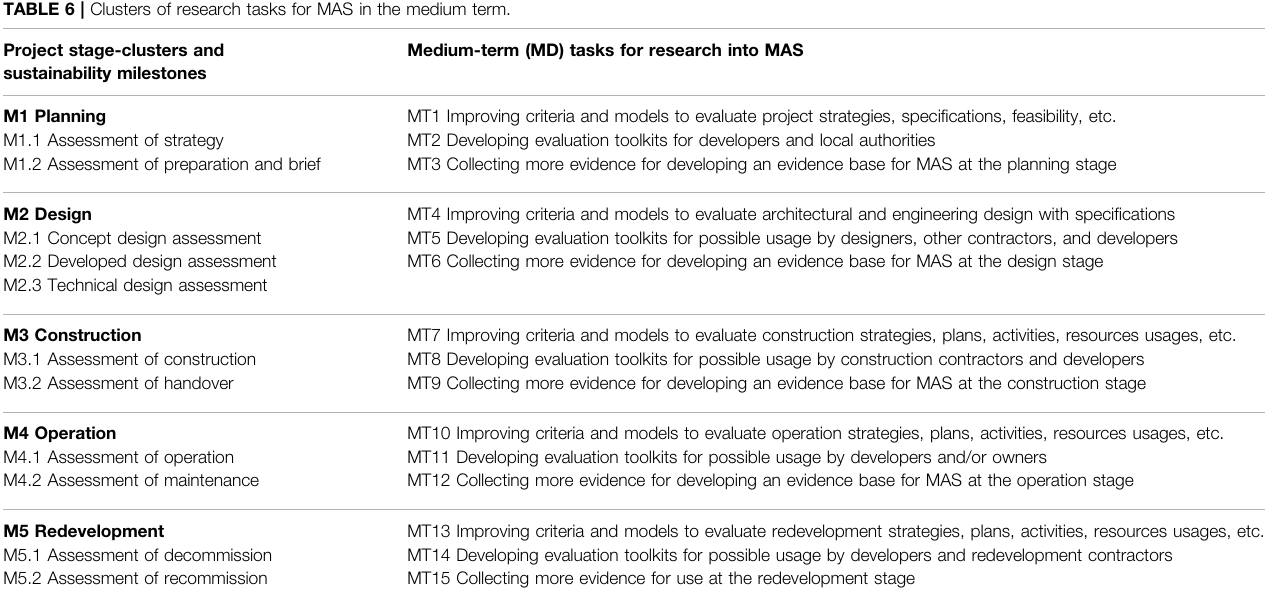
TABLE 6 | Clusters of research tasks for MAS in the medium